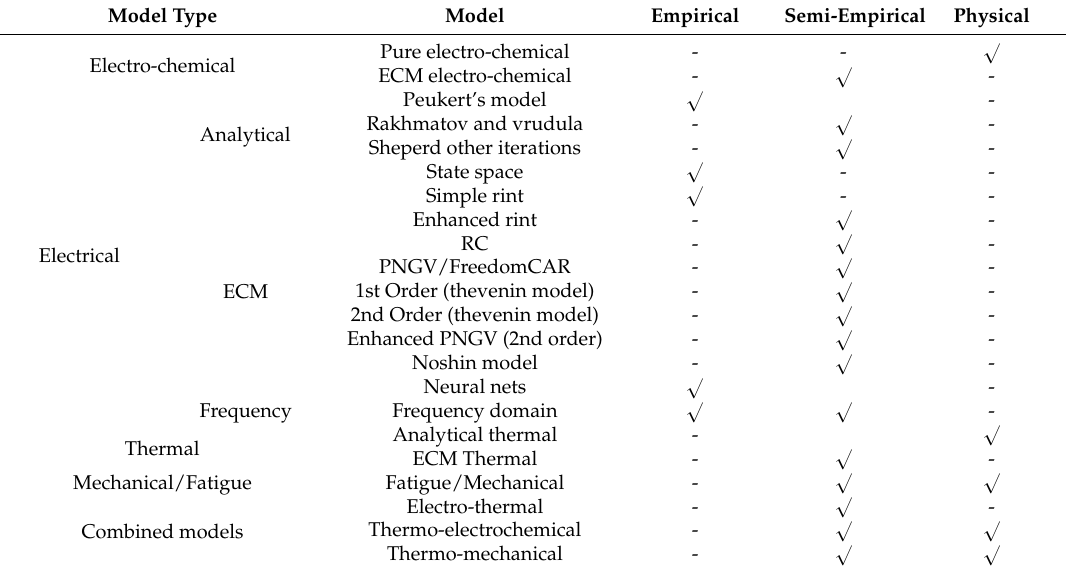
Table 2. Classification of different lithium-ion models [28]. ECM: equivalent circuit models; RC: combination of resistances and capacitance; PNGV: partnership for a new generation of